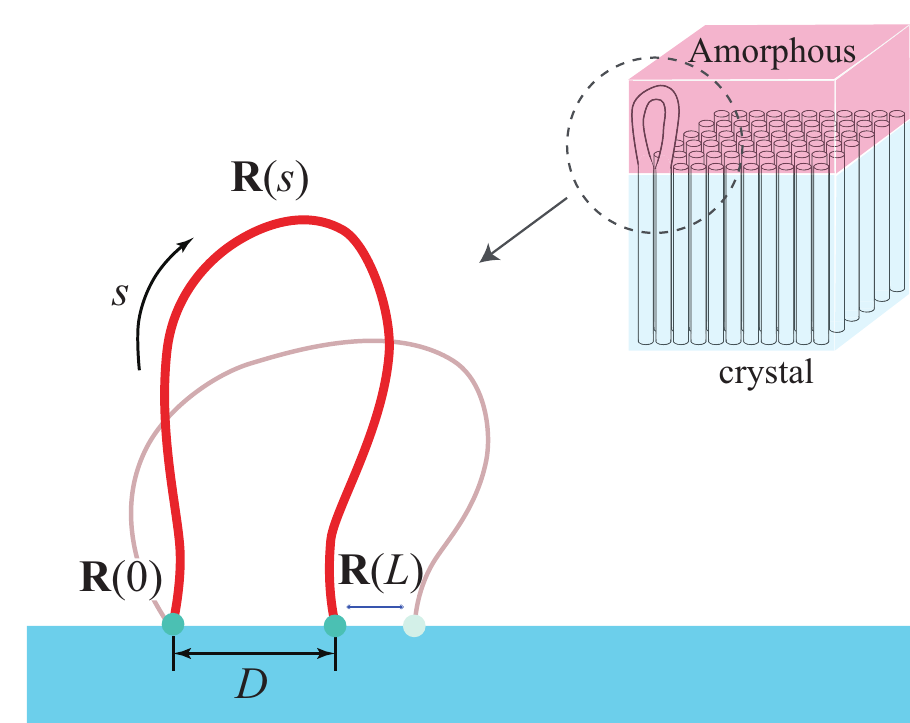
Figure 1. Schematic diagram of the local-exchange model for polymer crystal-amorphous